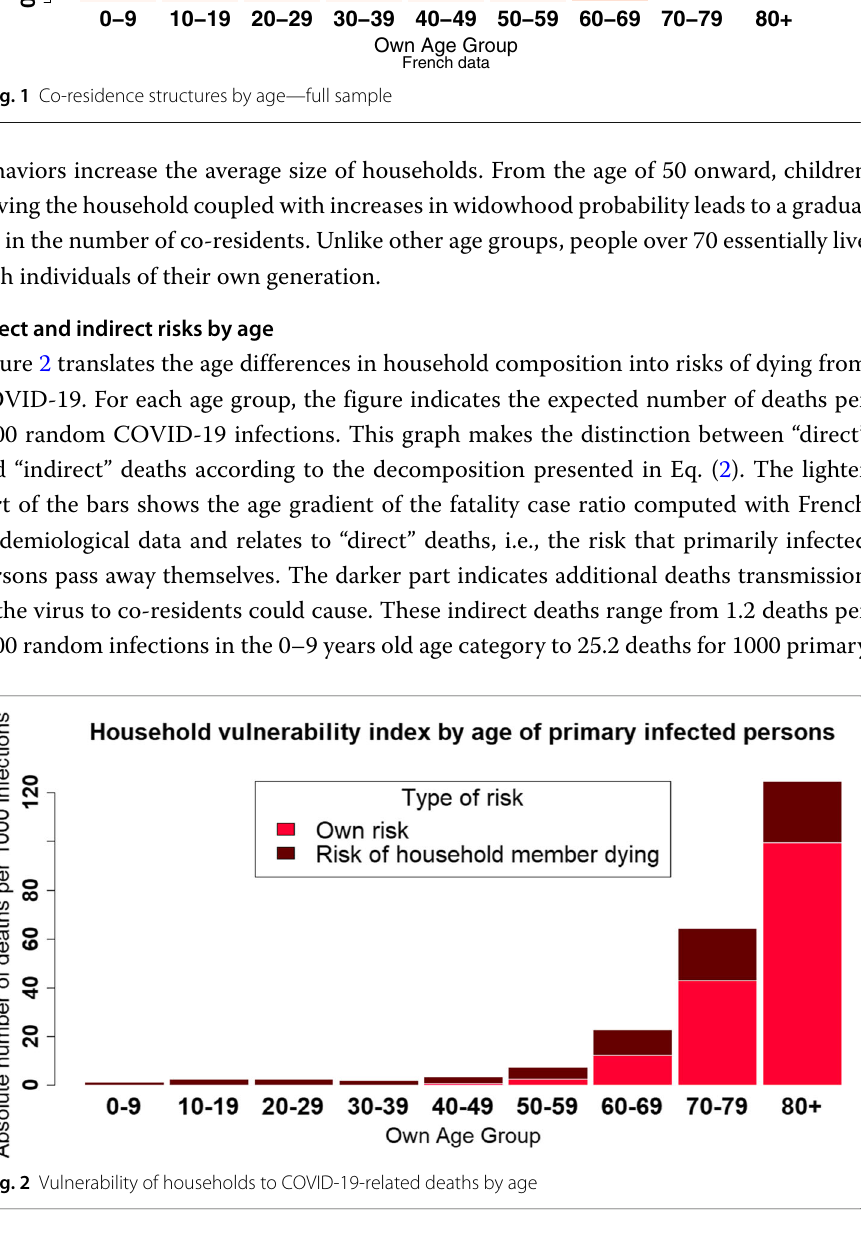
Fig. 2 Vulnerability of households to COVID-19-related deaths by